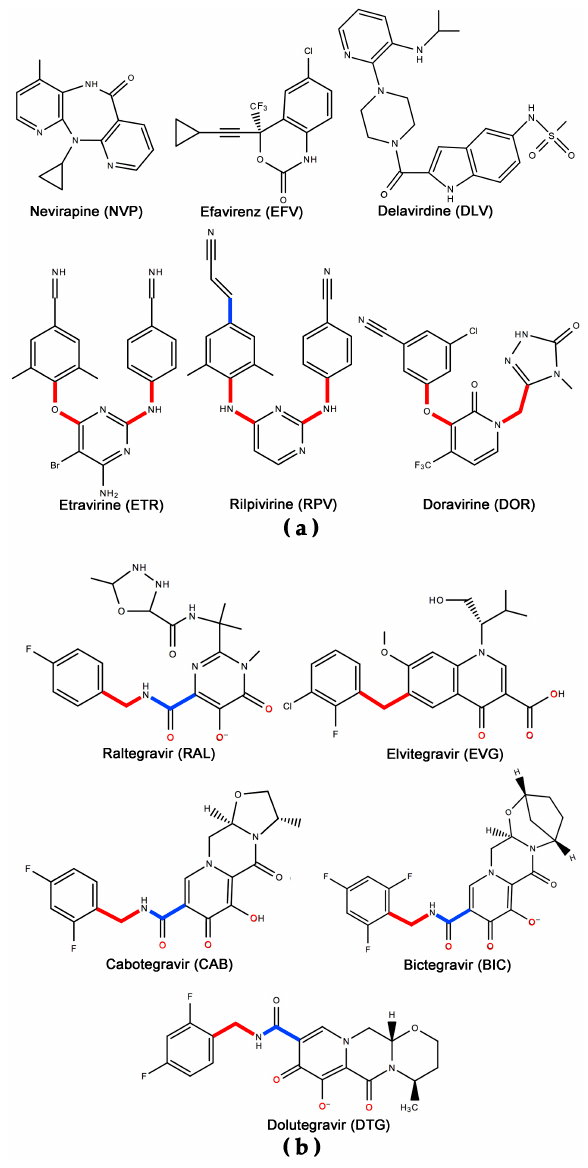
Figure 1. NNRTI-class and IN strand transfer inhibitor (INSTI)-class drugs. Chemical structures are shown for some NNRTIs ( a ) and INSTIs (b) currently approved or in trials [42,66–68] . Important single bonds with broad rotational flexibility are shown in red or with partial flexibility in